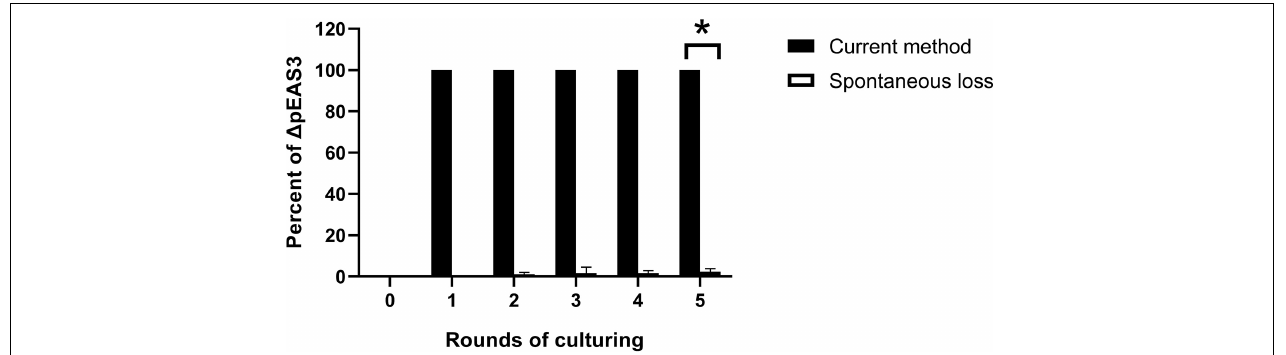
FIGURE 2 | Percentage of pESA3 plasmid-cured isolates after continuous culturing. The method described in the present study represents a strategy for plasmid curing in C. sakazakii , and the spontaneous loss of an endogenous plasmid represents the traditional molecular method based on plasmid incompatibility using another plasmid with the same replicon. The loss of the plasmid was verified by plasmid-specific PCR using primers listed in Table 3 . At the beginning of the experiment, 10 5 CFU/mL bacteria harboring the integrated plasmid pCs- (cid:49) pESA3 ( Figure 1B ) and bacteria harboring the incompatible plasmid pUC57-RepFIB were prepared and subsequently continuously cultured in LB containing sucrose and ampicillin, respectively. The cultures were shaken overnight at 37 ◦ C and then inoculated into 20 mL of fresh sterile LB medium at a 1:100 dilution the next day. After each round of culturing, bacterial samples were serially diluted and plated on agar to obtain signal colonies. Finally, 100 single colonies were selected, and their genotypes were determined by PCR using plasmid-specific primers. Each data point represents the average and standard deviation of three biological repeats. Student’s t-test; * P <